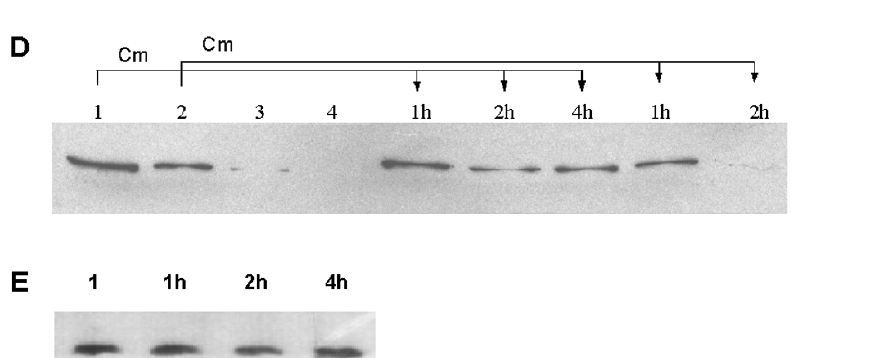
Figure 5 Smc transcription and SMC levels during different phases of growth. A) Samples 1 to 4 were taken at the time points indicated in the growth curve (note that an OD of 0.5 is in the middle of exponential growth). B) Primer extension analysis of transcripts from growth phases shown in (A), arrowheads indicate the two start bases. C) Organization of the smc region. The two start bases are shown in the black box. The promoter region as derived from primer extension analysis lies within the rncS gene as indicated, and is highlighted in the dashed boxes in the sequence. The start of the smc gene is boxed, and the position of the primer used is underlined. RncS and smc genes are shown in italics. D) Western blot analysis of SMC during growth phases 1 to 4 (lanes 1, 2, 3, and 4). Cells from phases 1 and 2 were incubated after addition of chloramphenicol (Cm) as indicated by the arrows for 1, 2 or 4 hours (1 h, 2 h or 4 h). E) Western blot of CspB during growth phase 1, and 1, 2 or 4 hours after addition of